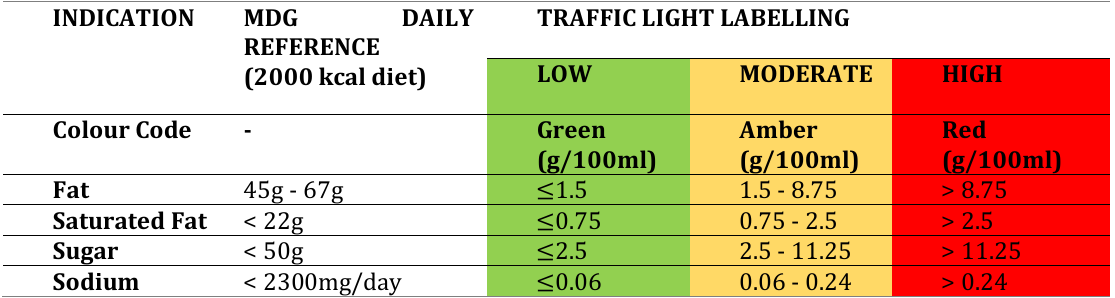
Table 3: Cut-Offs used for traffic light labels for a usual beverage serving based on Malaysian Dietary Guidelines